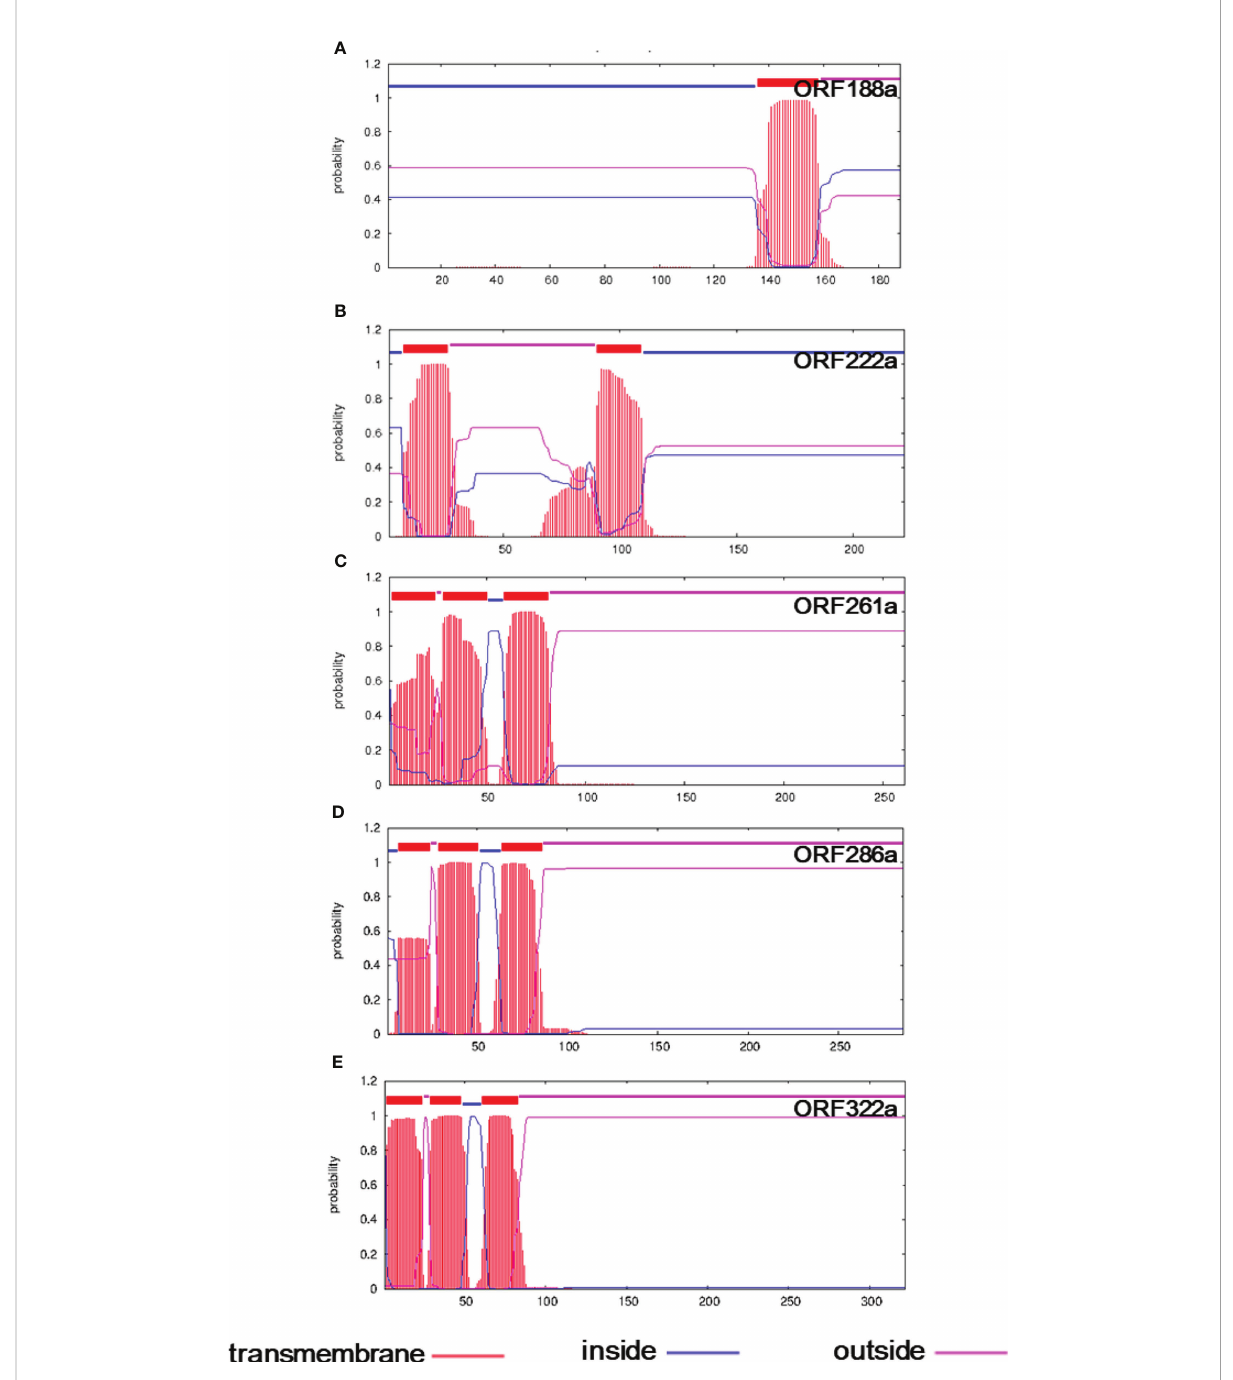
FIGURE 6 Transmembrane domain prediction of candidate CMS gene-encoded proteins in the C5-CMS line. The output of the TMHMM server indicated the location and probability associated with the predicted transmembrane domains in the C5-CMS line. (A) ORF188a, (B) ORF222a, (C) ORF261a, (D) ORF286a, and (E)